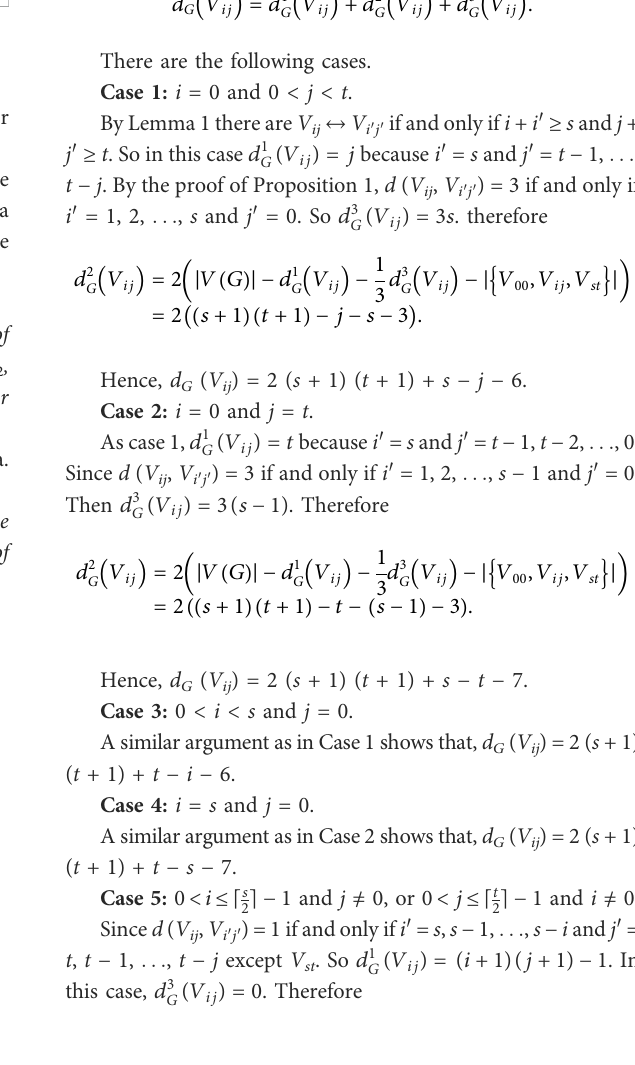
FIGURE 1 the compressed zero-divisor graph Γ E ( Z 2 2 ×3 3 )